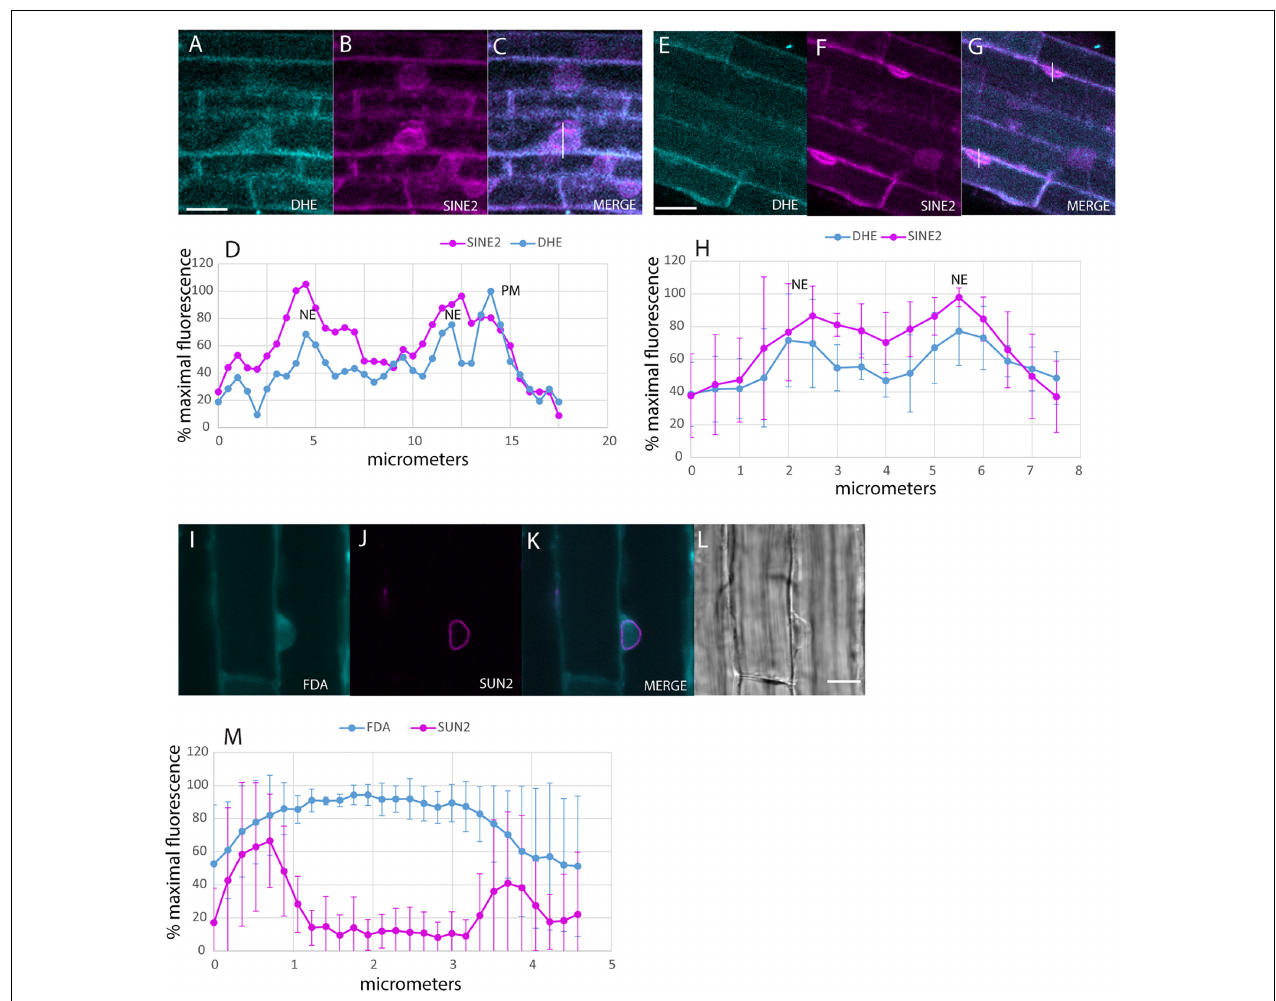
FIGURE 2 | Labeling of the NE with DHE in elongating root cells. (A–C) Seedlings expressing SINE2-GFP were incubated for 30 min in DHE and fluorescence after multiphoton excitation was measured. (A) Emission at 405/20 nm for DHE. (B) Emission at 525/50 nm for SINE2-GFP. (C) Merged image of the DHE signal (cyan) and the SINE2-GFP signal (magenta). Scale bar = 20 µ m. (D) Profile plot of line shown in (C) . PM indicates peak from PM. NE indicates peaks from the membranes of the NE. (E–G) Seedlings expressing SINE2-GFP were incubated for 30 min in DHE as in (A) , but the nuclei of these cells lie against the PM. (E) DHE signal. (F) SINE2-GFP signal. (G) Merged image. (H) Averages of profile plots of five similarly sized (smaller than the nucleus in A–D ) nuclei show a bimodal distribution of intensity peaking at the NE. The error bars indicate standard deviation. (I–L) Seedlings expressing SUN-RFP were incubated for 30 min in the vital dye fluorescein diacetate to label the cytoplasm. (I) Fluorescein signal. (J) SUN-RFP signal. (K) Merged image. Scale bar = 10 µ m. (L) Bright-field image. (M) Average of five profile plots of nuclei that lie against the PM, including the one shown in (I–L) . The error bars indicate standard